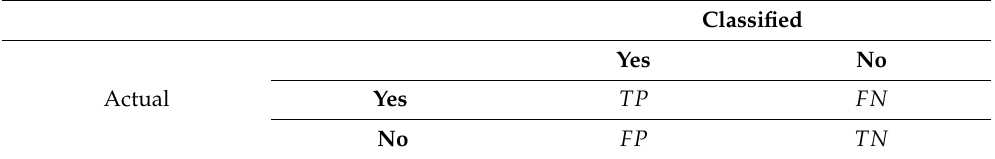
Table 6. Confusion matrix for the classification of actual and classified yes or no, with actual and classified, respectively, as True Positive ( TP ) for Yes–Yes, False Negative ( FN ) for Yes–No, False Positive ( FP ) for No–Yes and True Negative ( TN ) for